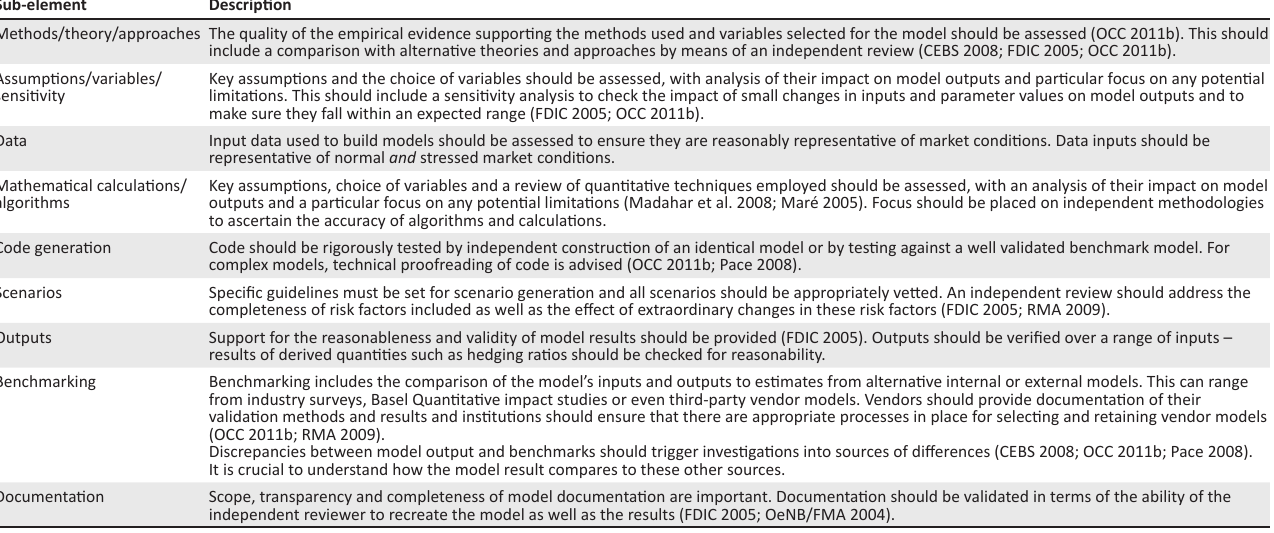
TABLE 1: Conceptual soundness and developmental evidence. Sub-element Description